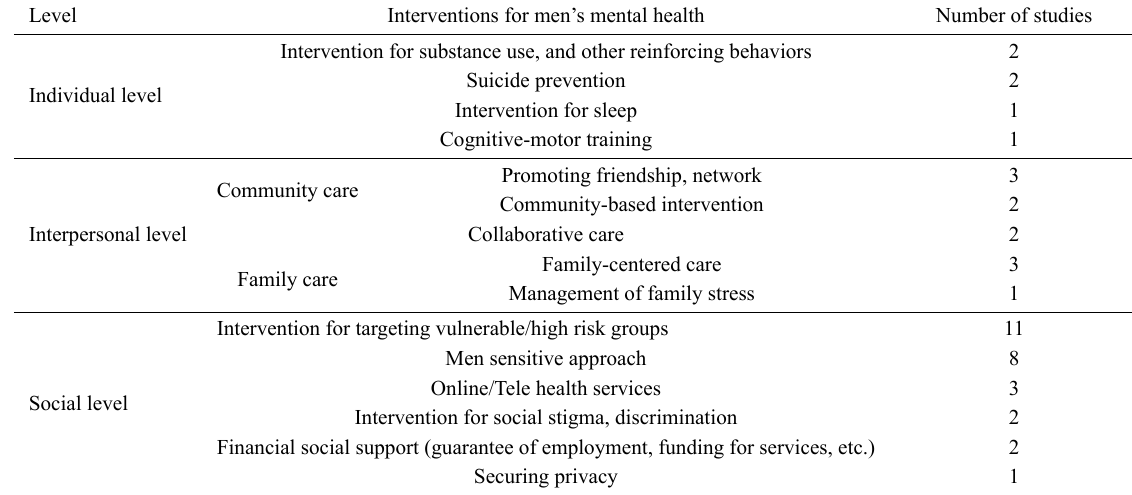
Table 3. Numbers of studies about interventions for men’s mental